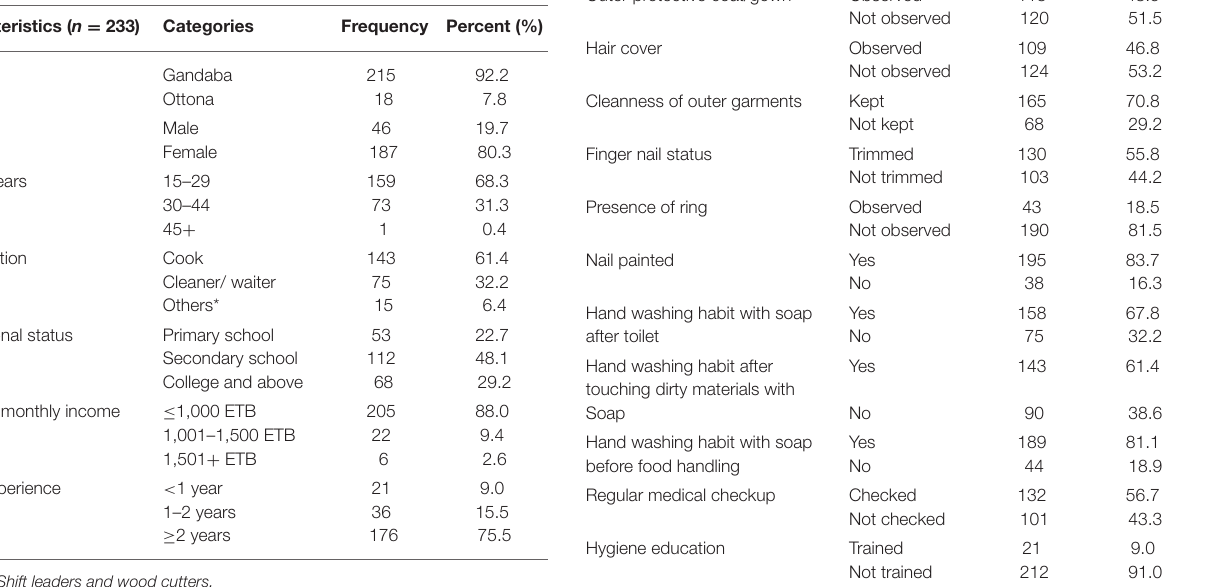
TABLE 1 | Socio-demographic characteristics of the food handlers worked in the students’ caterings of WSU, Wolaita Sodo, South Ethiopia from January 10 to February 10, 2016.